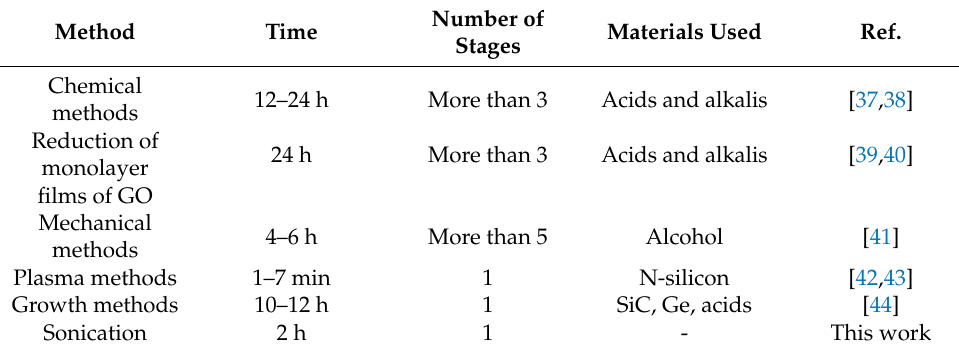
Table 1. The main methods of obtaining graphene.